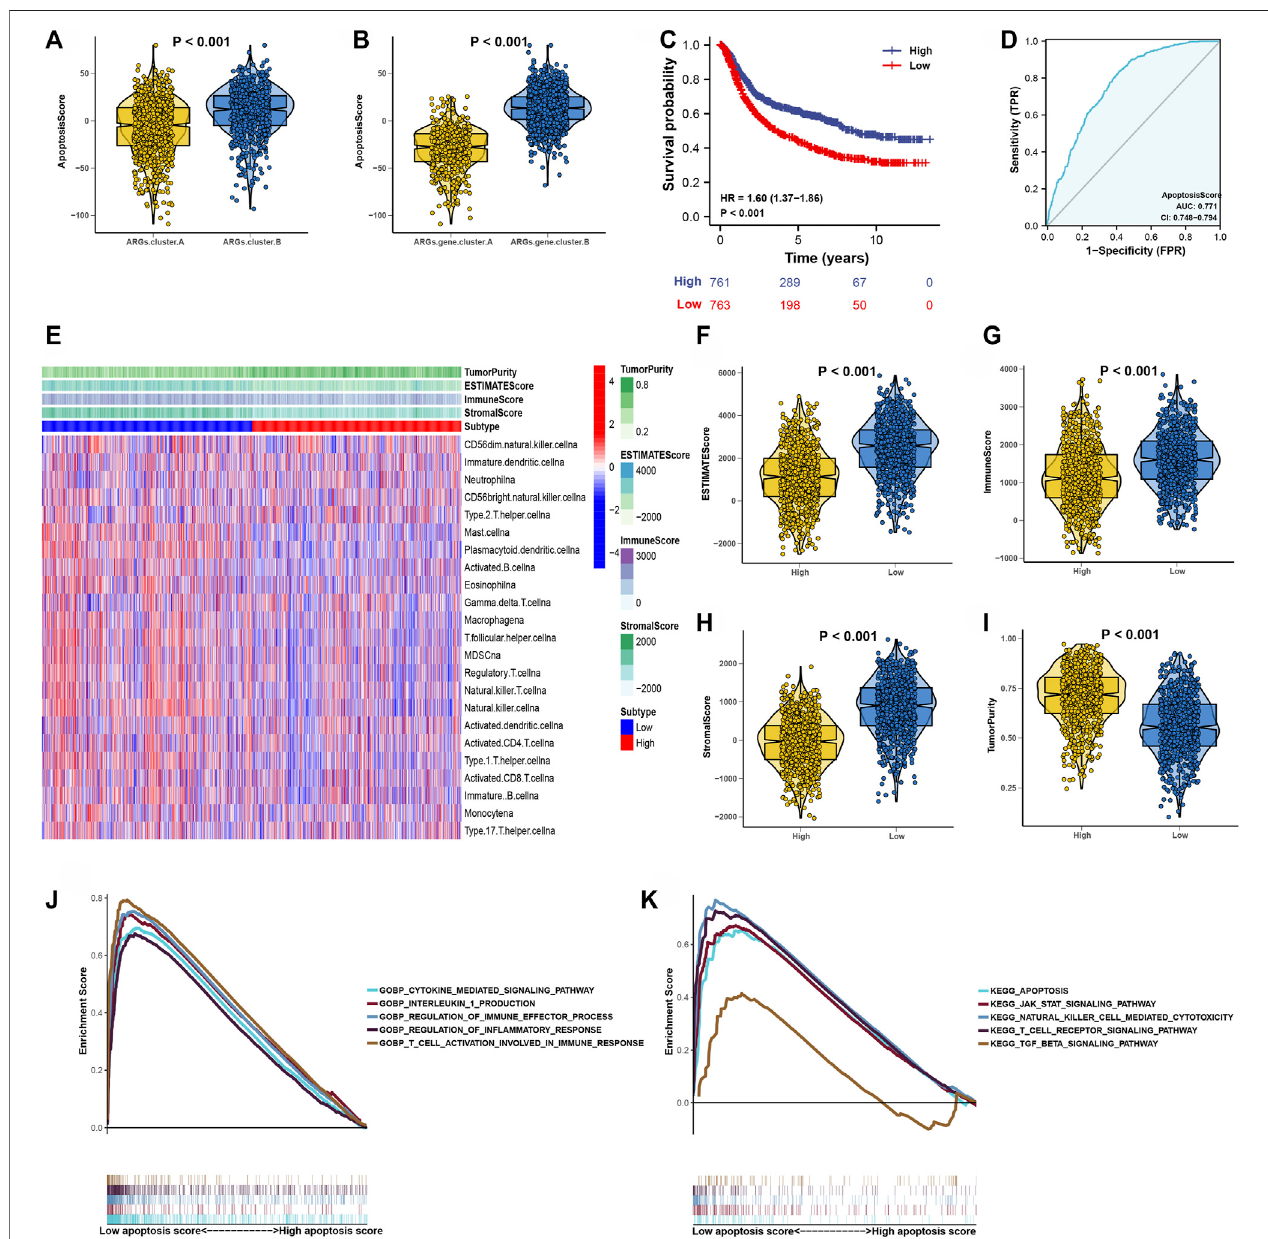
FIGURE 5 | Construction of apoptosisScore. (A) Differences in apoptosisScore among two ARGs. (B) Differences in apoptosisScore among two ARGs.gene.clusters. (C) Kaplan-Meier curves for high and low apoptosisScore groups. (D) The predictive value of apoptosisScore. (E) The correlation of tumor microenvironmentconditioninhighandlowapoptosisScorepatientgroups. (F – I) TheESTIMATEscore,stromalscore,immunescore,andtumorimmunitylevelsinhigh and lowapoptosisScoregroups byusingESTIMATE algorithm. (J) GSEA GOidenti fi ed highand lowapoptosisScoregroupsrelated signaling pathways inGC. (K) GSEA KEGG identi fi ed high and low apoptosisScore related signaling pathways in